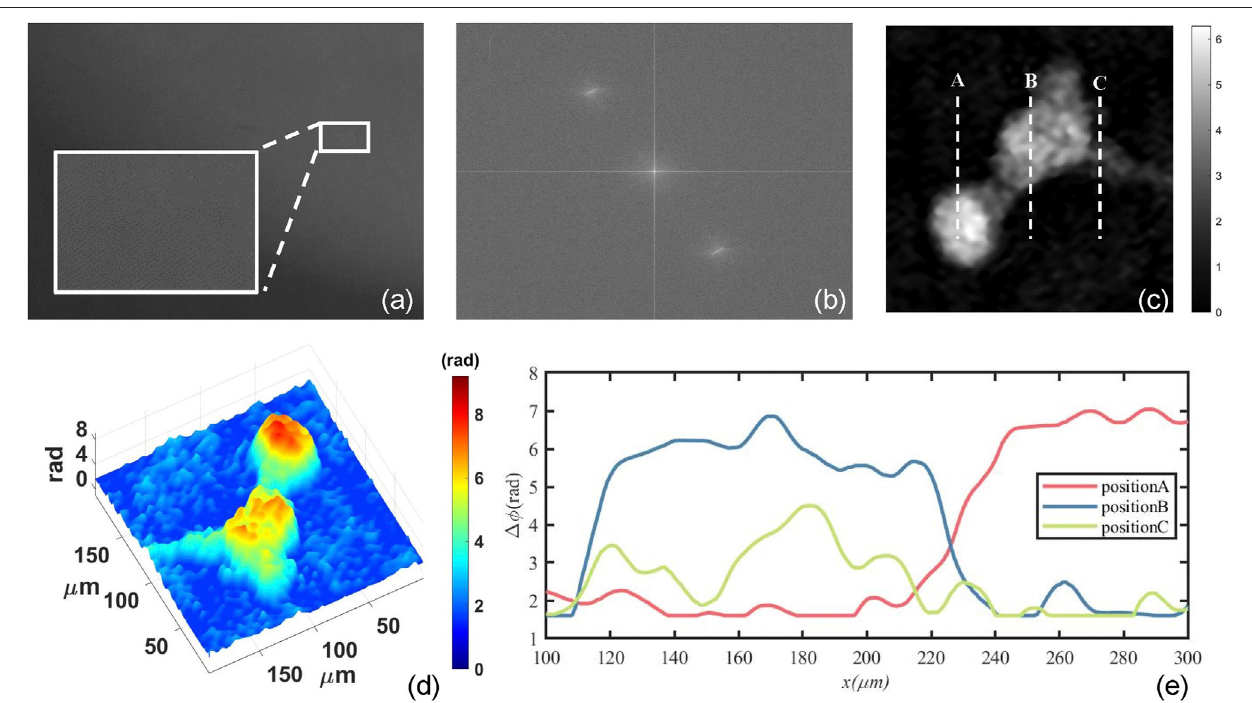
FIGURE 2 | Numerical reconstruction results of mouse osteoblastic cells by use of convolution algorithm. (A) The digital holograms of a living mouse osteoblastic cell; (B) The spectrum of the hologram; (C) The quantitative two-dimensional phase map of one mouse osteoblastic cell; (D) three-dimensional phase map; (E) The pro fi le map along with the dash lines A, B and C in (C) .